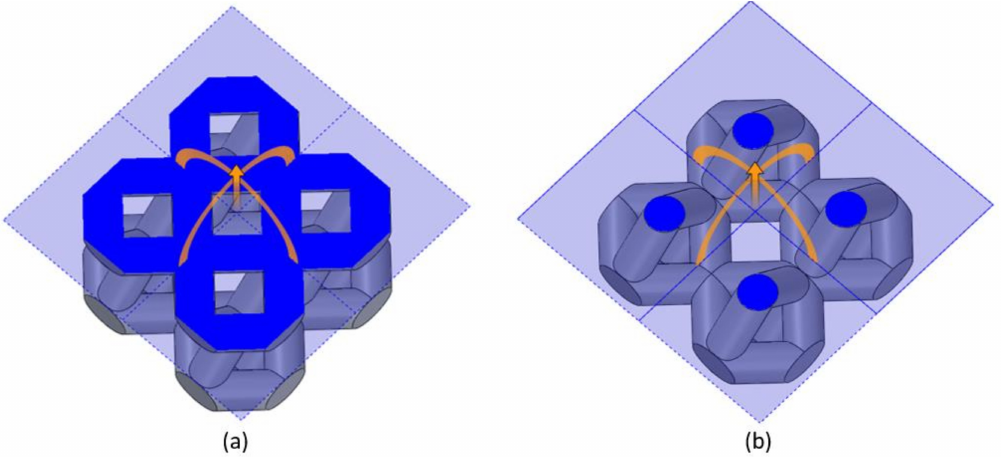
Figure 6. Maximum and minimum areas of the compression lattice model: ( a ) maximum area and ( b ) minimum